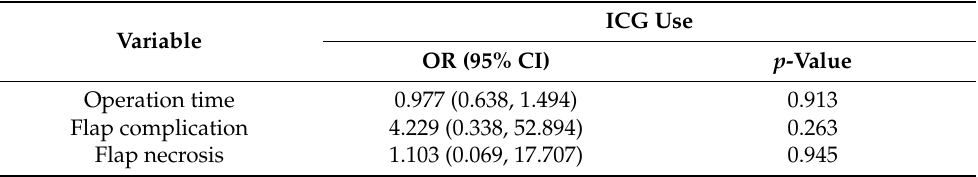
Table 3. Logistic regression analyzing impact of ICG device on operation time, incidence of compli- cation and flap